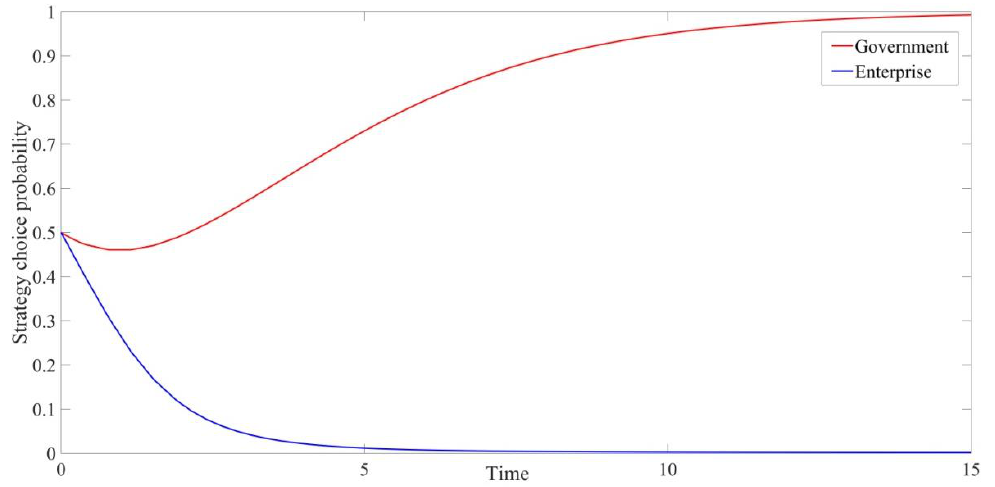
Figure 7. Simulation results of the partial equilibrium point (0,1).